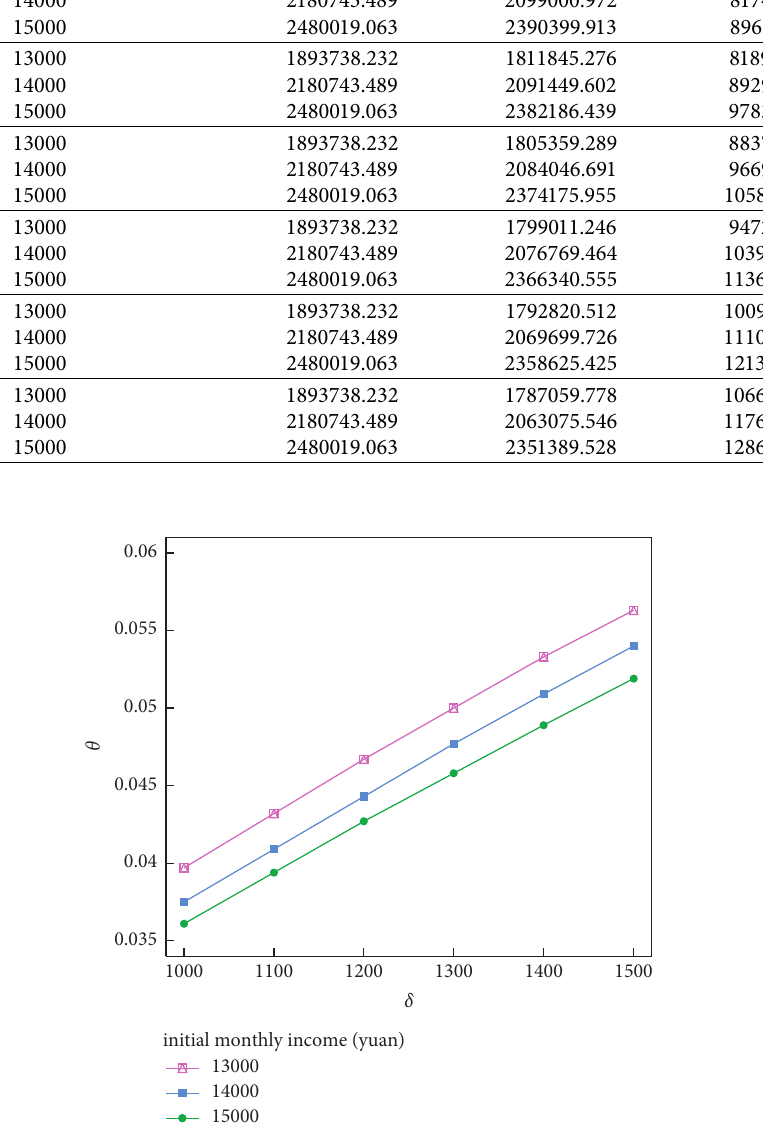
Figure 3: Tax-saving rate under different insurance amount tax